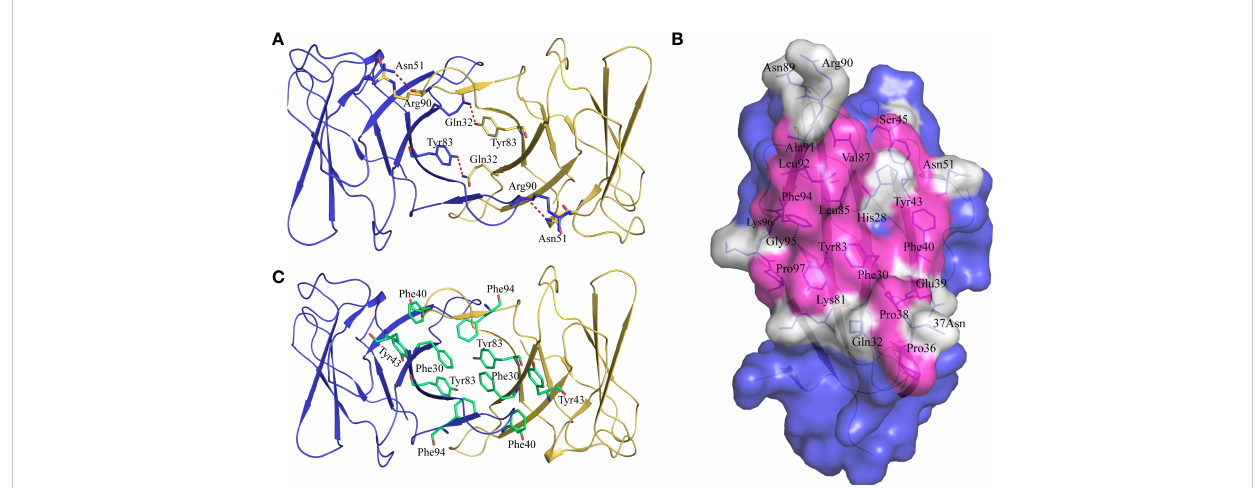
FIGURE 4 Characterization of the intermolecular interactions that maintain the dimerization of ScCD8 aa . (A) The inter-chain hydrogen bonds of Sc CD8 aa . The Sc CD8 aa is shown in cartoon representation with the monomers colored blue and orange. Side chains that assist dimerization through the formation of hydrogen bonds are shown as stick models with their amino acid and position labeled. Hydrogen bonds are shown as red dashed lines. (B) The residues in the interface of the Sc CD8 aa . Sc CD8 a is surface rendered in blue. The residues forming the interface are shown as sticks and surface rendered in white while hydrophobic residues are surface rendered in magenta. Amino acid residues and their positions are labeled. (C) Side chains forming the hydrophobic core of Sc CD8 aa . The backbone of Sc CD8 aa is shown as a cartoon with the monomers colored blue and orange. The residues forming the hydrophobic core are shown as stick models and colored lime green. Amino acid residues and their positions are labeled.